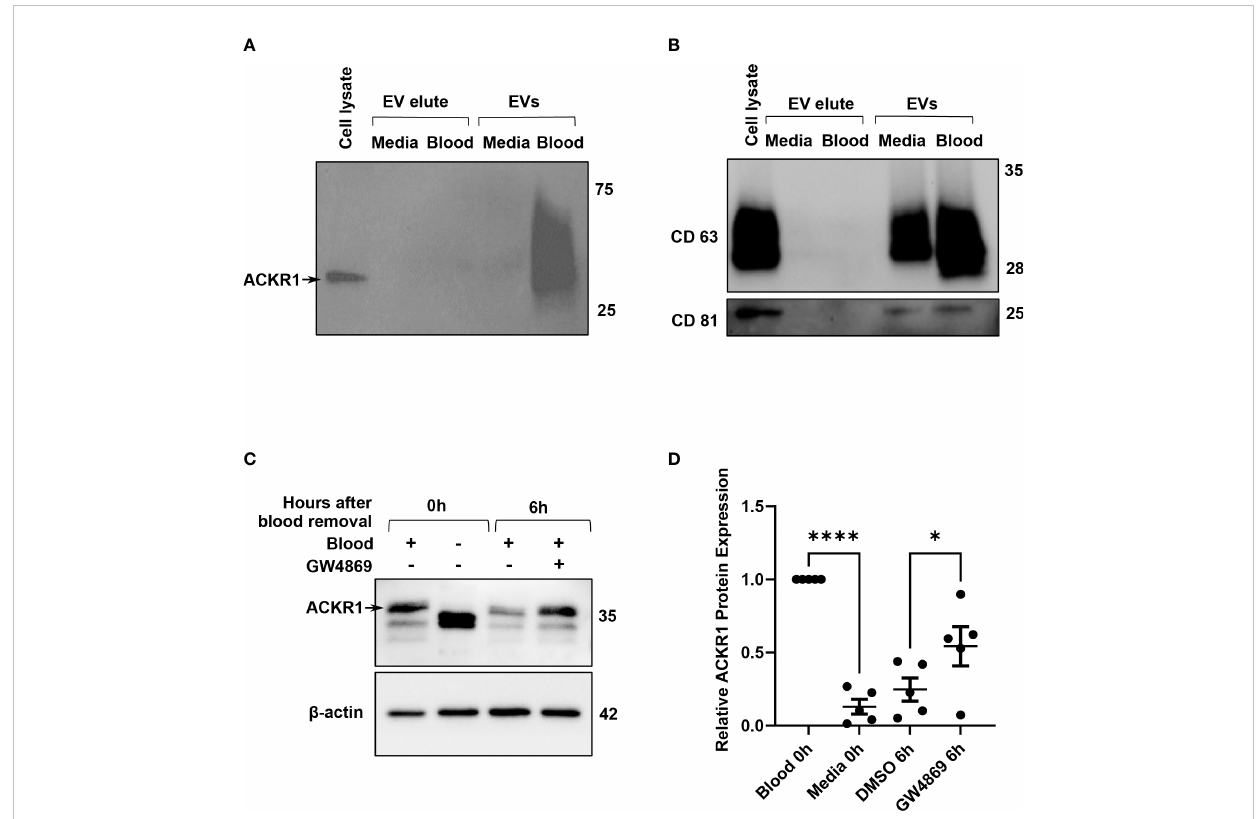
FIGURE 7 ACKR1 is secreted in extracellular vesicles after removal of blood. HPMECs were incubated with blood or media for 24 hours and subsequently washed and incubated with serum-free media for 6 hours. (A, B) Extracellular vesicles (EVs) in the supernatant at 6 hours after blood removal were isolated by size-exclusion chromatography; ACKR1 (using the NBP2-75197 antibody) and EV markers CD63 and CD81 were detected by immunoblotting. (C) Cells were treated with the EV inhibitor GW4869 (2 m M) after blood removal for 6 hours. Blot shows whole cell lysate at 0 and 6 hours after blood removal with or without the inhibitor. (D) Quanti fi cation of ACKR1 levels in cell lysates (****p<0.0001;